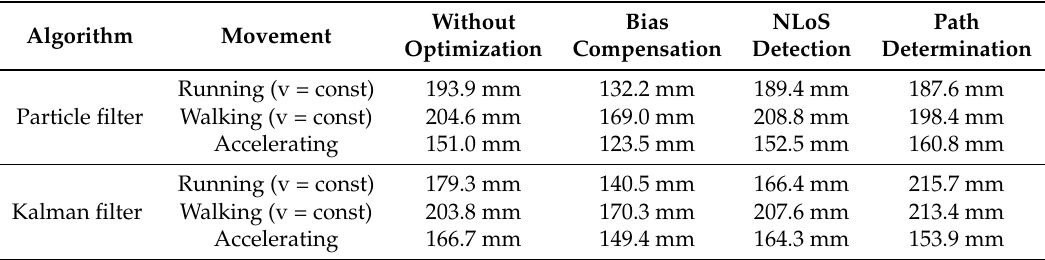
Table 4. Mean absolute error (MAE) when using algorithmic optimizations for the head position case, with the particle filter, and the Kalman filter. NLoS: non-line-of-sight.